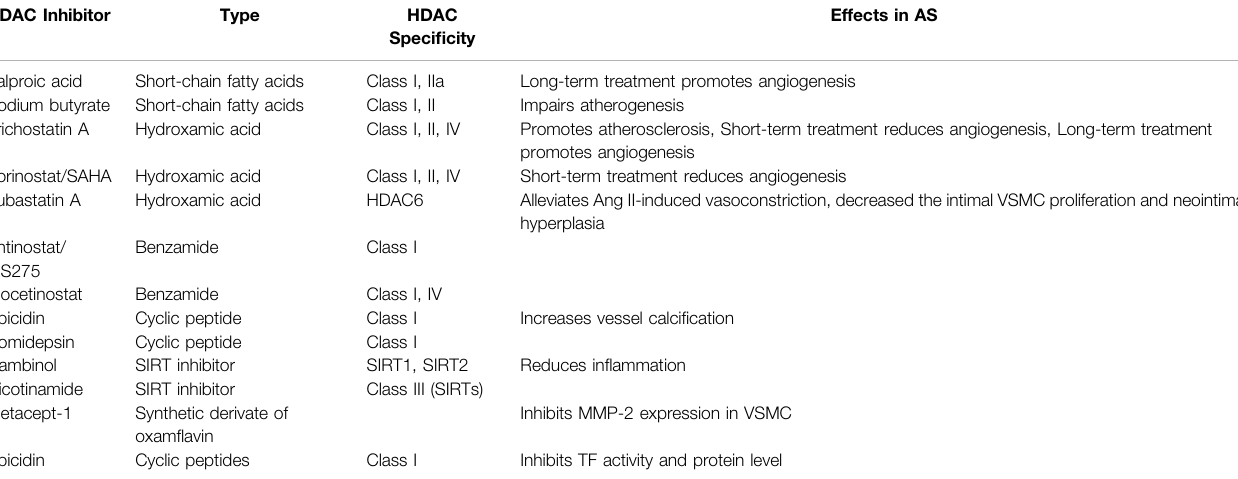
TABLE 2 | Effects of HDACis in